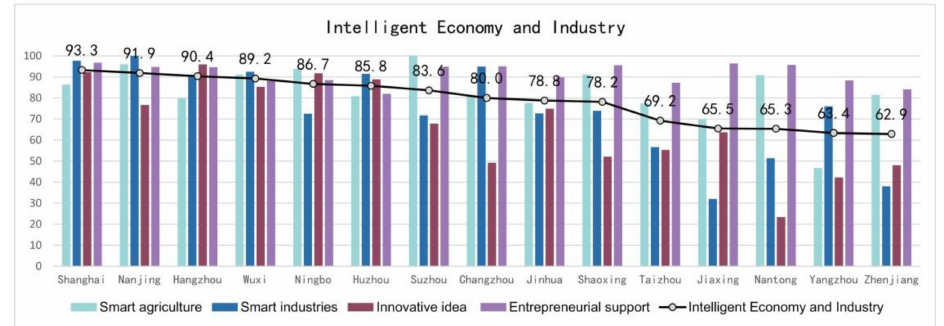
Figure 7. CityIQ scores for the ‘Intelligent Economy and Industry’ dimension of the fifteen major cities in the Yangtze River Delta region, China.